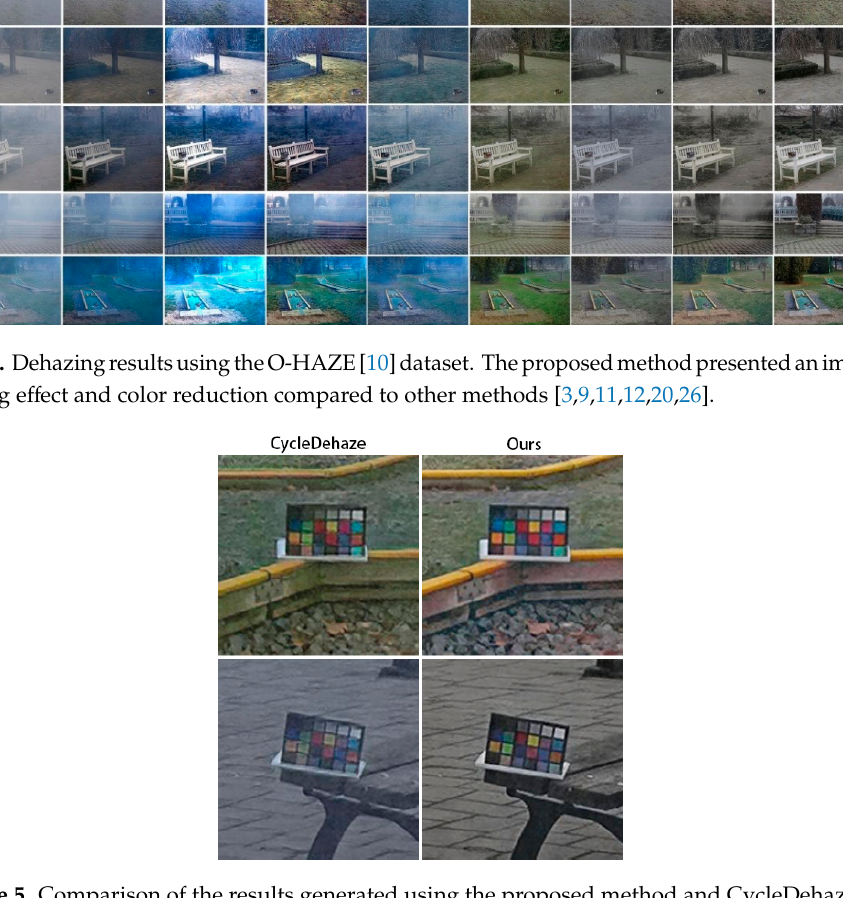
Figure 5. Comparison of the results generated using the proposed method and CycleDehaze [9].